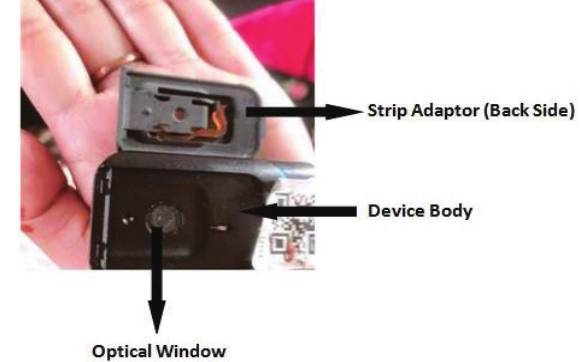
Fig-5: Optical window exposed after sliding strip adaptor from the device body Retesting after optical window servicing: After the device optical window was cleaned, a series of duplicate tests were run on randomly selected